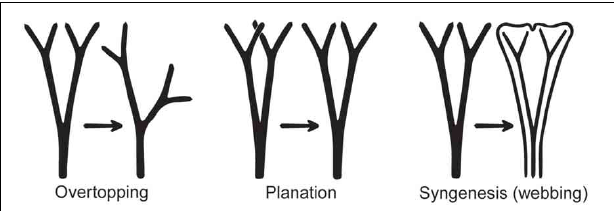
FIGURE 4 | Three processes from the telome theory proposed to be involved in megaphyll evolution (redrawn from Zimmermann, 1952). These processes may have occurred in various sequences in different groups of vascular